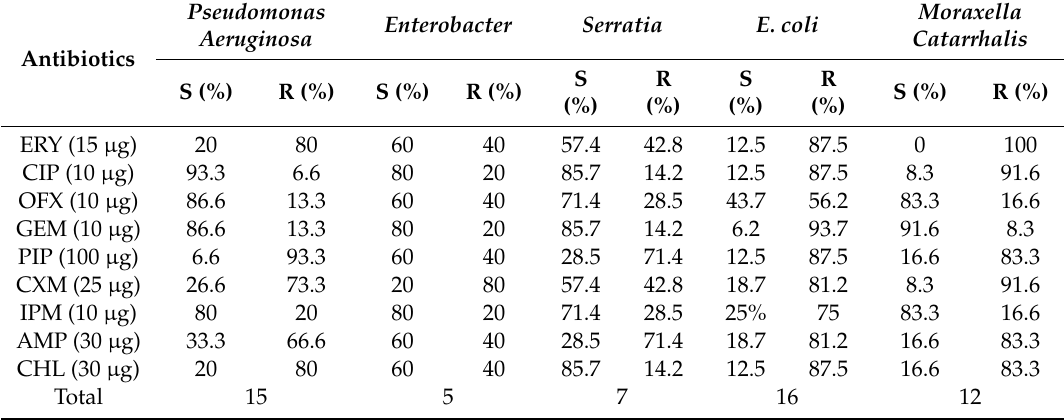
Table 1. Antibiotic susceptibility pattern of isolates in percentage is calculated according to the number of positive isolates present in the examined samples (S—Sensitive, R—Resistance).